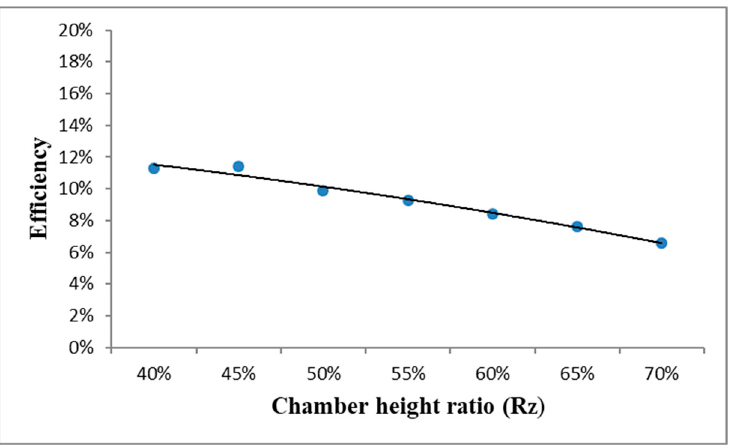
Figure 21. Efficiency corresponding to height-ratio of OWC chamber.